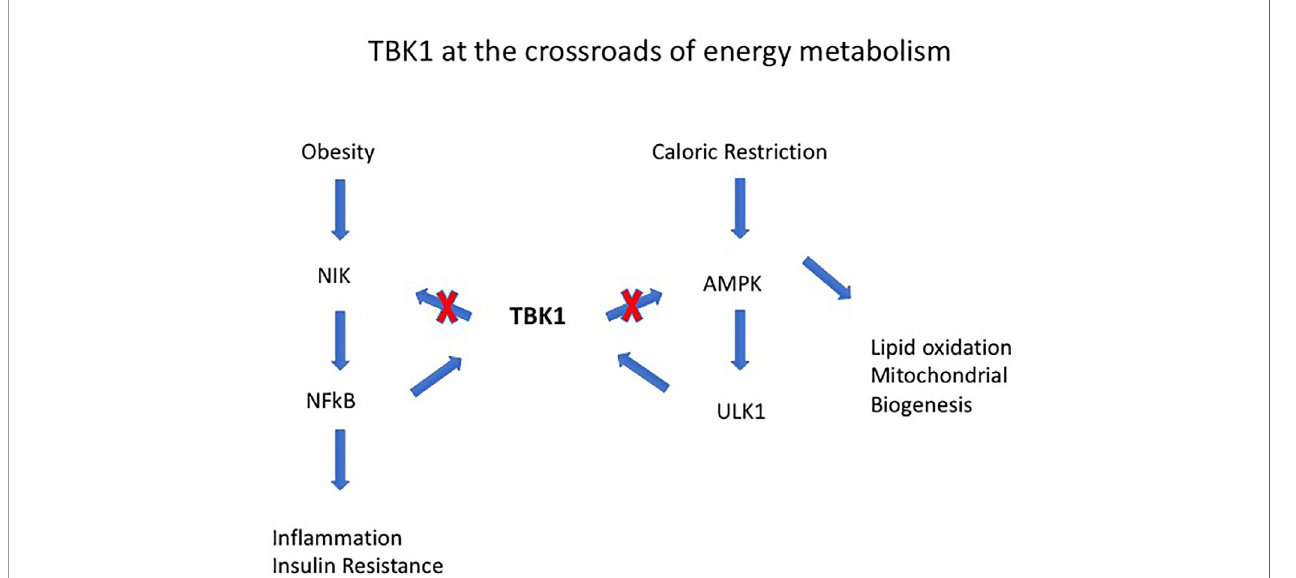
FIGURE 3 | Tank-binding protein kinase 1 (TBK1) operates at the intersection of energy expenditure and in fl ammation. For instance, TBK1 de fi ciency attenuates HFD-induced obesity but exaggerates in fl ammation through its effects on NF-kB – inducing kinase (NIK). TBK1 represses energy expenditure by phosphorylating and inhibiting AMPK and to the serine-threonine kinase Unc-51-Like Autophagy Activating Kinase 1 (ULK1). The combined effects of TBK1 are to attenuate NF-kB activation and mediate the anti-in fl ammatory effect of AMPK [from Zhao et al.